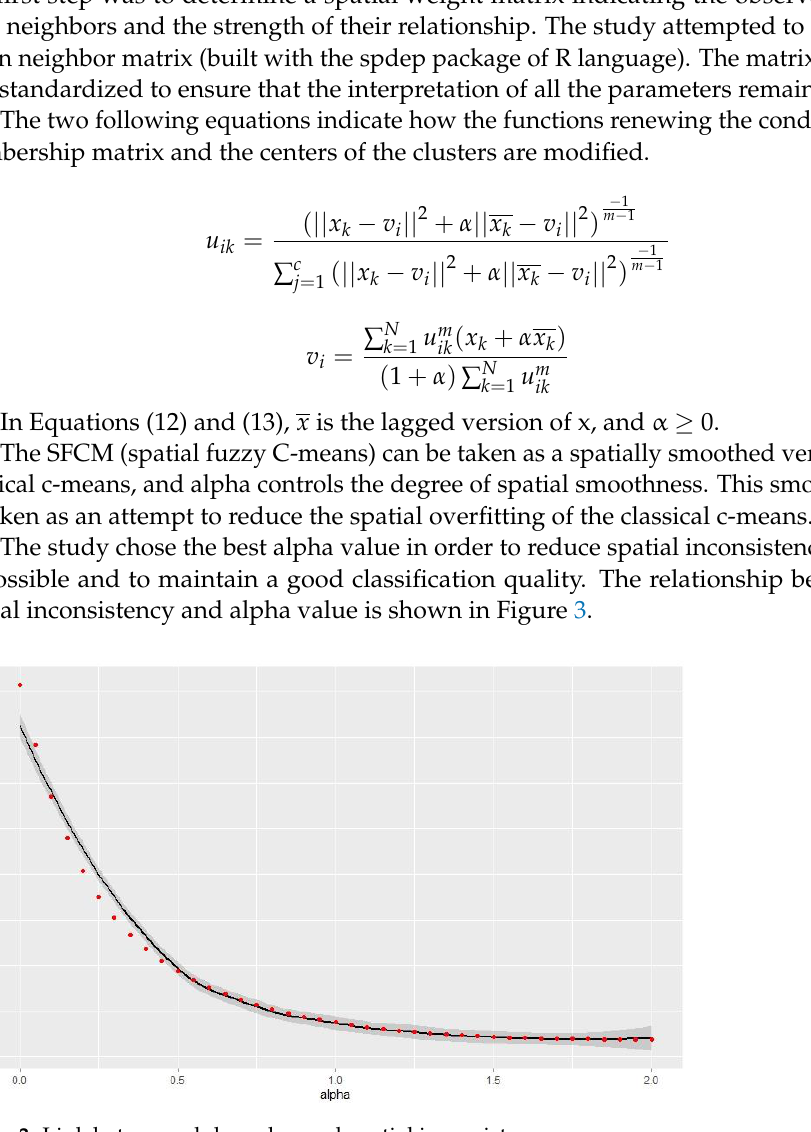
Figure 3. Link between alpha value and spatial inconsistency.